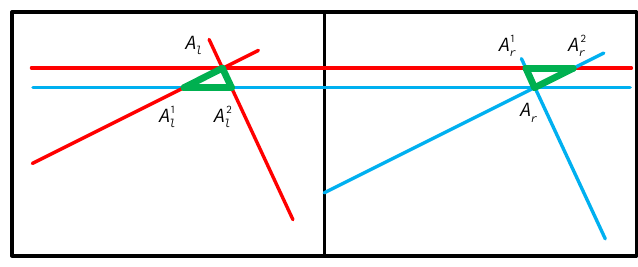
Figure 13. Schematic of non-collinear problem for matching